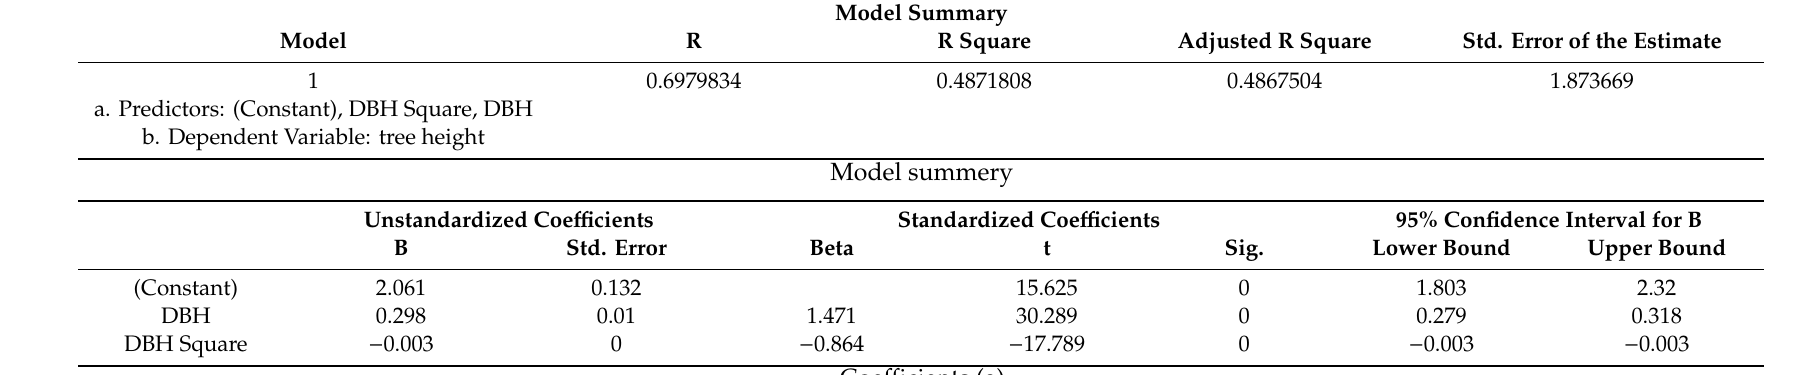
Table 2. Height–diameter regression model.